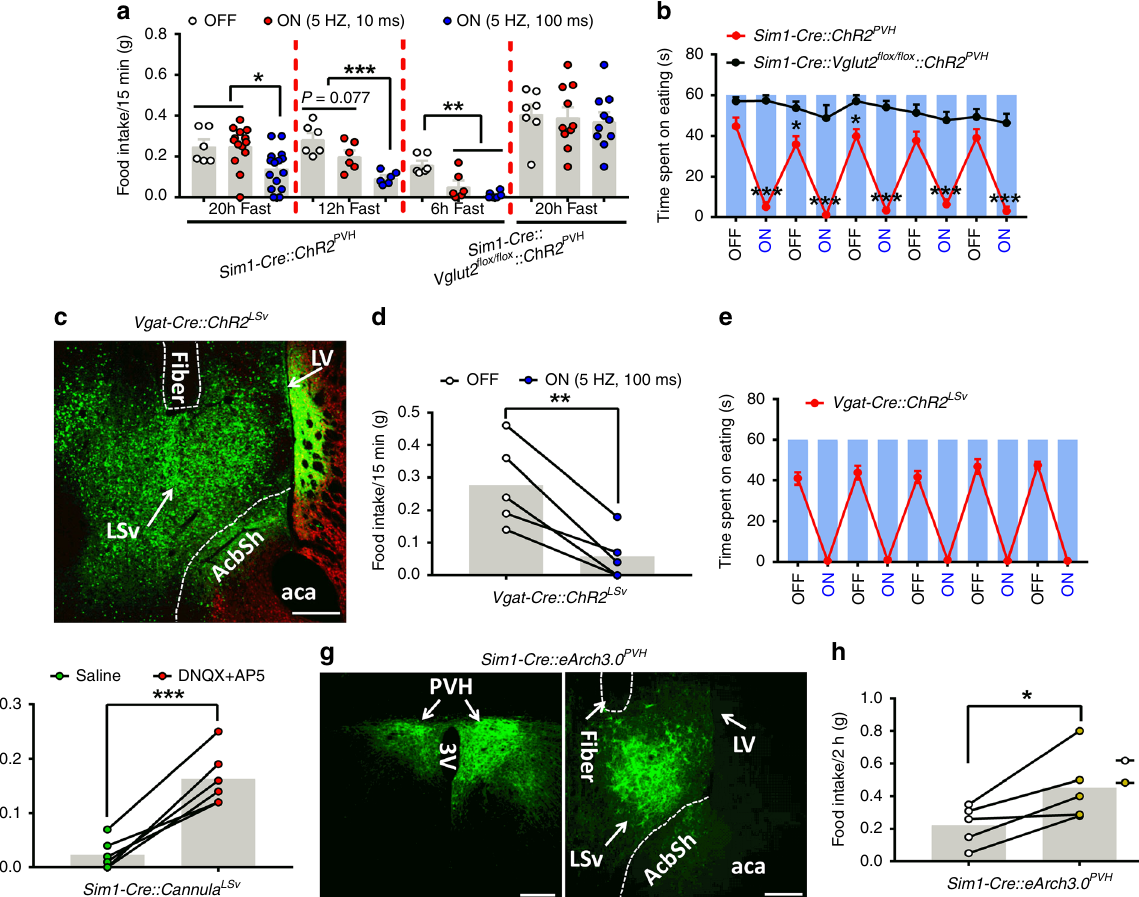
Fig. 5 PVH → LSv projections regulate feeding. Sim1-Cre and Sim1-Cre::Vglut2 fl ox/ fl ox male mice with AAV-Flex-ChR2-eGFP delivery to the PVH and fi ber optic implantation targeting LSv were used for feeding assays. a Measurements of food intake over 15 mins after either 20 hr ( n = 6 – 15, OFF vs 5 HZ,100 ms p = 0.0306; 5 HZ,10ms vs 5 HZ,100 ms p = 0.0108), 12 hr ( n = 6, OFF or 5 HZ,100 ms vs 5 HZ,100ms, p < 0.0001) or 6 hr ( n = 6, p = 0.0002) fasting with no photostimulatoin (OFF), long pulse (100 ms/5 Hz, 5 mW/mm 2 ), or short pulse photostimulation (10 ms/5 Hz, 5 mW/mm 2 ). b Measurements of feeding time with alternating segments of laser off (OFF) and on (ON, 100 ms/5 Hz, 5 mW/mm 2 ) at 1 min each ( n = 5 – 8/group, p < 0.001, p = 0.0277, or p = 0.0181; also online Movie 4, Source data are provided as a Source Data fi le). c – e A representative image showing AAV-Flex-ChR2-eGFP expression and optic fi ber implantation trace in the LSv of Vgat-Cre animals after stereotaxic delivery of the vector to LSv c , feeding was measured for 15 mins after 12 hr fasting with no light (OFF), long pulse photostimulation (ON) ( d , n = 5, p = 0.0049), or measured with alternating segments of laser off (OFF) and the long pulse (ON) at 1 min each ( n = 5) ( e , also online Movie 5, Source data are provided as a Source Data fi le). f Well-fed mice with cannulation targeting LSv were measured for feeding 20 mins after infusion of AP5 + DNQX or saline ( n = 5, p < 0.0001, also online Movie 6). g – h Well-fed Sim1-Cre mice with AAV- Flex-ArchT3.0-eGFP bilateral delivery to PVH ( g , left panel, arrows) and optic fi ber implantation targeting LSv harboring GFP-expressing fi bers ( g , right panel, arrows) were measured for feeding in 2 hrs with yellow laser off (OFF) and following a long pulse on (ON, n = 5, p = 0.0268) h . * p < 0.05, *** p <0.001, student ’ s t tests for comparison between two groups ( b , d , f , and h ) or ANOVA tests for comparison among three groups a . Scale bar = 100 µ M . PVH: paraventricular hypothalamus; LV: lateral ventricle; 3 V: the third ventricle; LSv: ventral part of lateral septum; aca: anterior commissure area; AcbSh: accumbens shell. Source